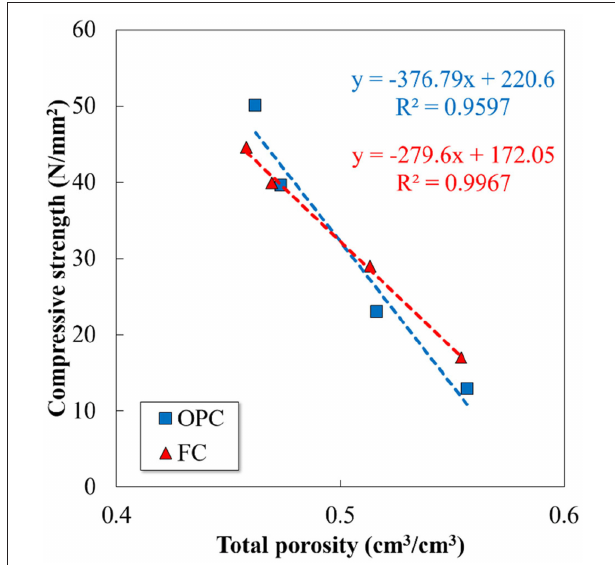
FIGURE 11 | Relationship between calculated total porosity and measured compressive